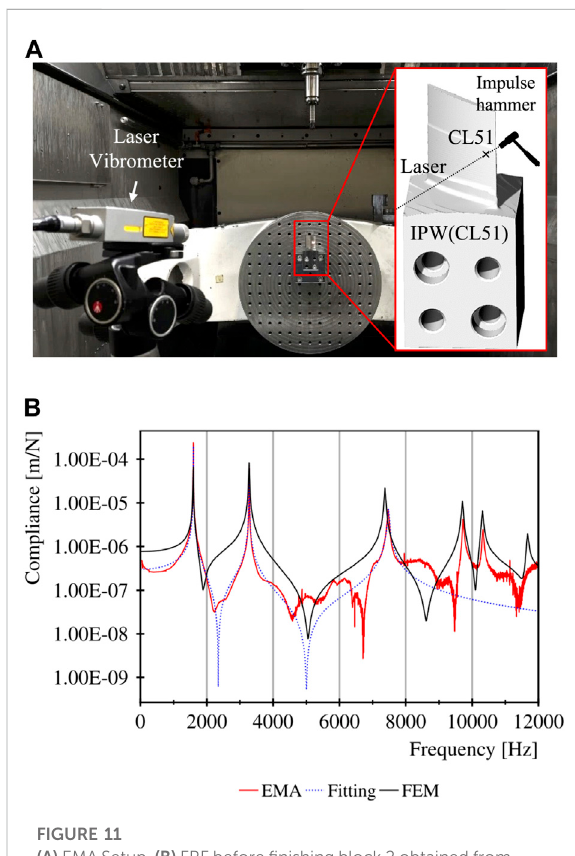
FIGURE 11 (A) EMA Setup, (B) FRF before fi nishing block 2 obtained from EMA (red); state-space model by system identi fi cation (blue); FE modal analysis for CL51